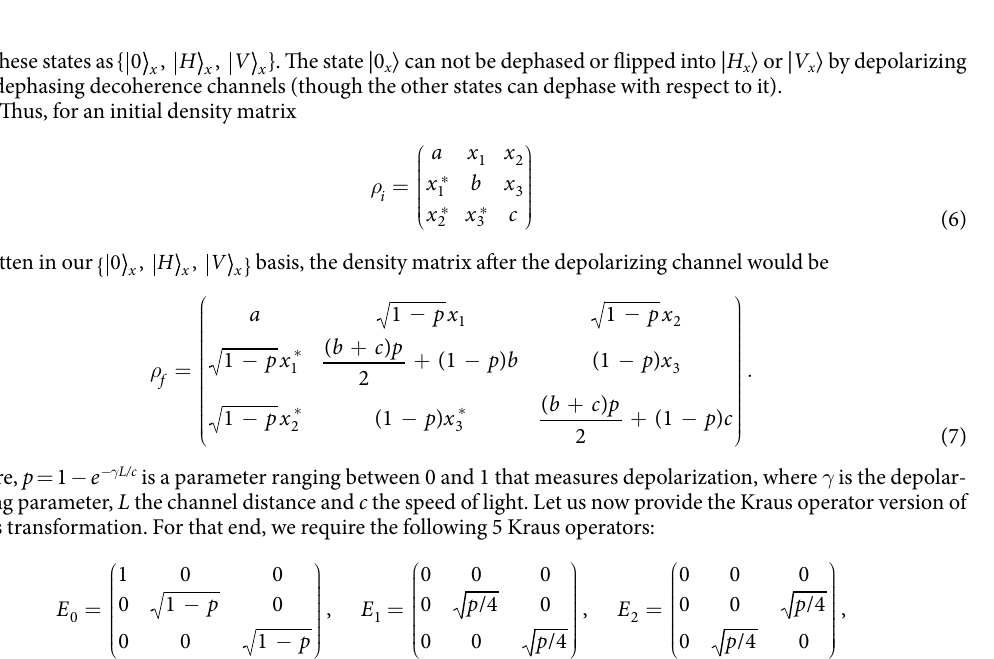
Figure 2. Alice wants to send an arbitrary qubit | ψ A 〉 = a 1 | H 〉 + a 2 | V 〉 to Bob. She writes and encodes her qubit using our previous quantum adder setup. She then sets her H waveplate, attenuator and retarder so that b 1 = 1, A = a 2 and φ = π , such that all single photons after BBO 2 have | ψ A 〉 independent polarizations. Afterwards, single photons are sent through decoherence channels and received by Bob. He projects them into their desired constant polarization, and attenuates his identical coherent laser to account for expected losses in the single photons. Finally, he feeds BBO 3 with those three signals, obtaining | ψ A 〉 in path (1) with a high success